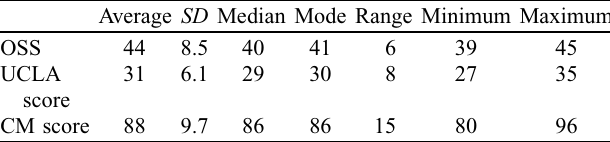
Table 4. Comparison between pre-operative primary outcome measures (shoulder scores) and 24 months post-operative.